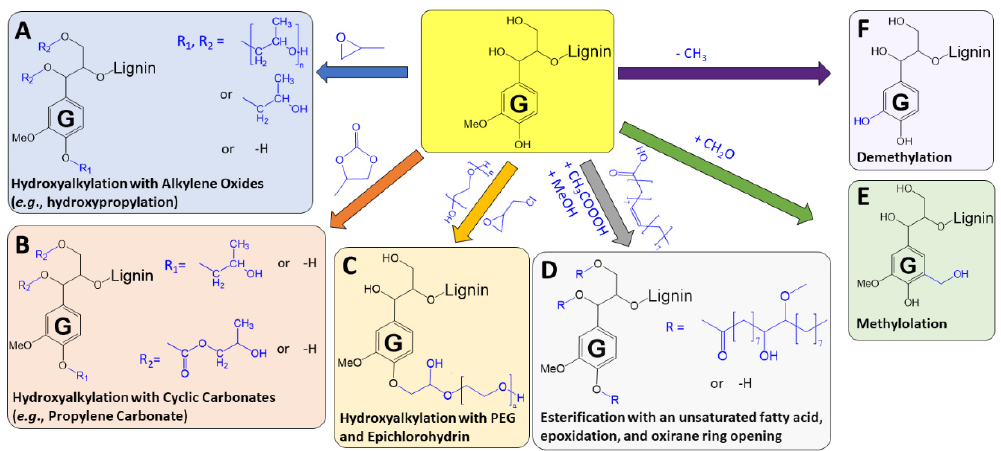
Figure 4. Example derivatization approaches for improving reactivity of a terminal guaiacyl monomer within a lignin polymer with an isocyanate and incorporation into PUs.